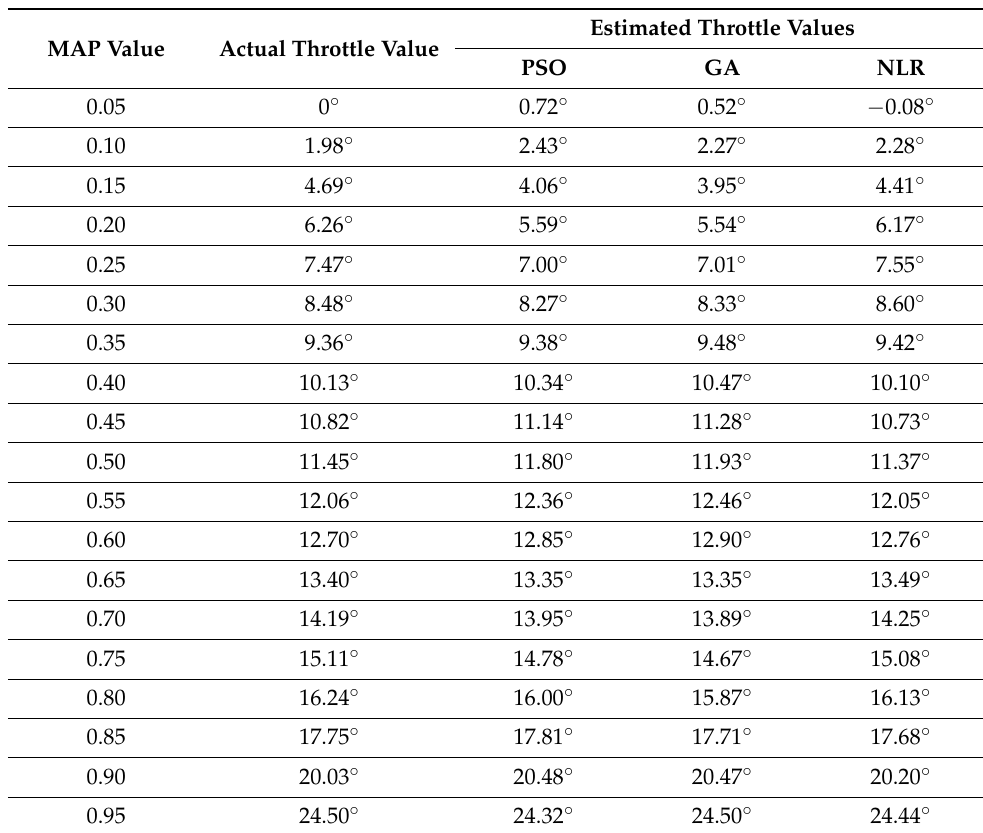
Table 8. Estimated throttle values with PSO, GA, and